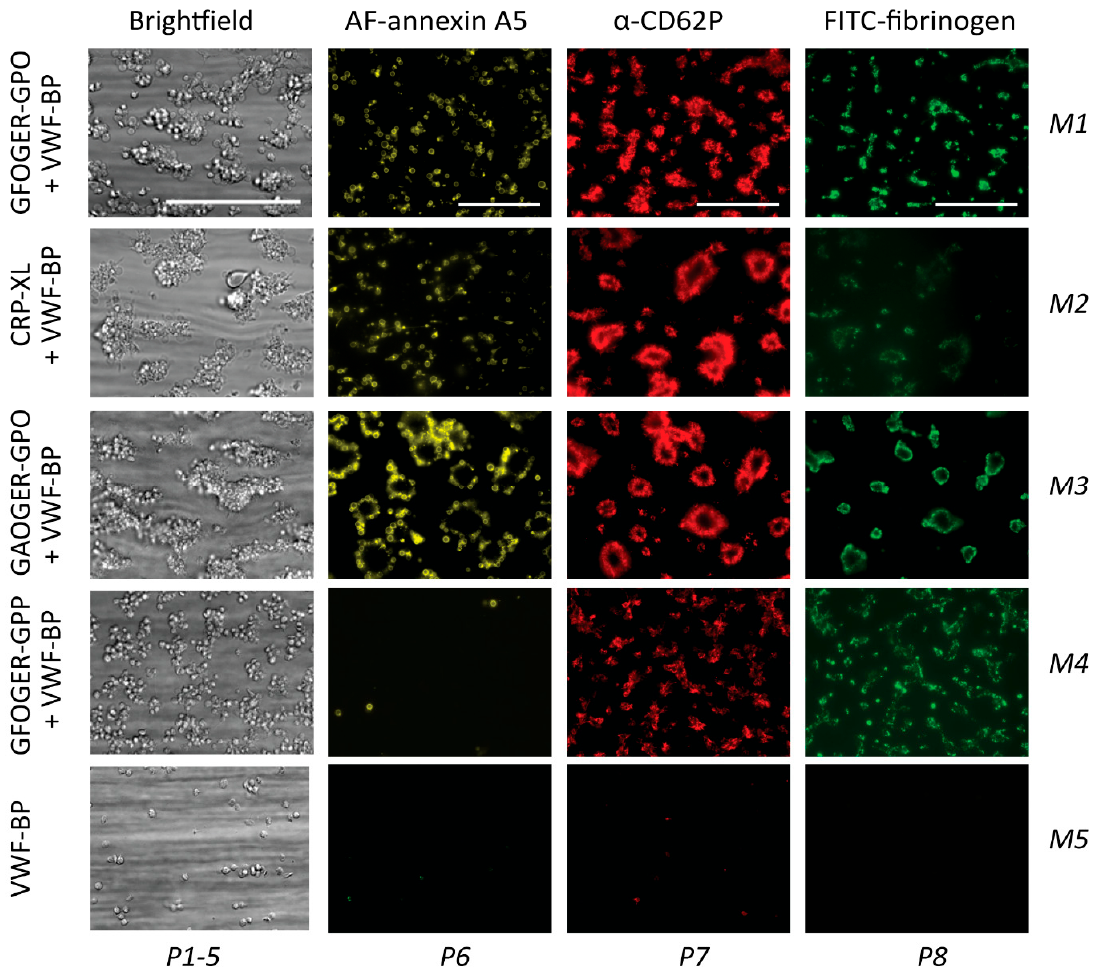
Figure 2. Thrombus formation on immobilized collagen peptides with or without a (GPO) n motif. Whole blood was perfused over microspots M1 (GFOGER-GPO + VWF-BP), M2 (CRP-XL + VWF-BP), M3 (GAOGER-GPO + VWF-BP), M4 (GFOGER-GPP + VWF-BP), and M5 (VWF-BP), with assumed platelet adhesion via GPIb, GPVI, and/or integrin α 2 β 1 , as in Table 1. The wall-shear rate was 1000 s − 1 , with a perfusion time of 3.5 min. Representative bright-field microscopic images at the end stage are shown for an analysis of platelet deposition (parameter P1) and thrombus characteristics (P2–5). In addition, end-stage three-color fluorescence images for an analysis of PS exposure (AF568 annexin A5, P6), CD62P expression (AF647 α -CD62P, P7), and fibrinogen binding (FITC, P8) are shown. Scale bars represent 50 µm.